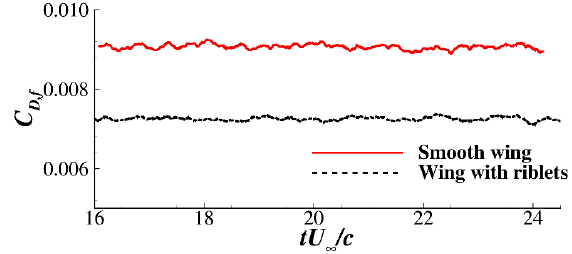
Figure 10. Aerodynamic force histories of the smooth wing and the wing with riblets.